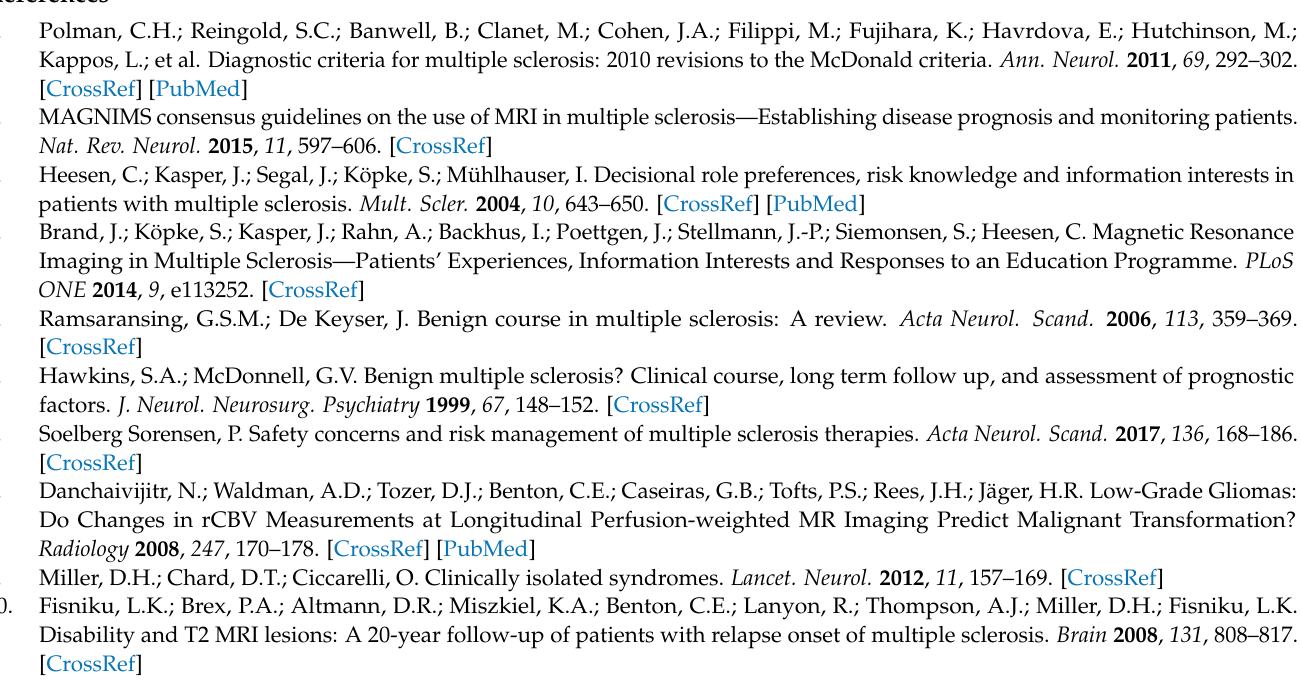
Table S1: MRI data, raters, and lesion segmentation details, Figure S2. Key elements for forest plot